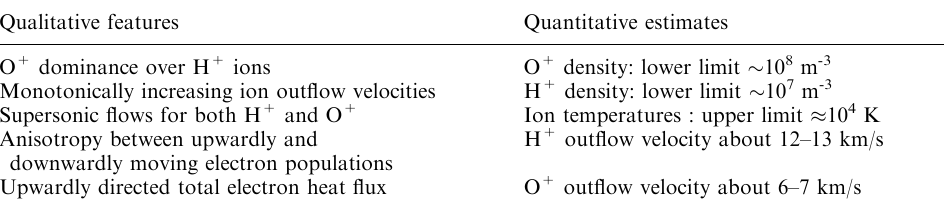
Table 2. Dayside polar wind observations by the Akebono satellite. Ion measurements we- re made at 5000–9000 km alti- tude (Abe et al ., 1993a). Electron observations were m- ade at about 1700 km altitude (Yau et al ., 1995)